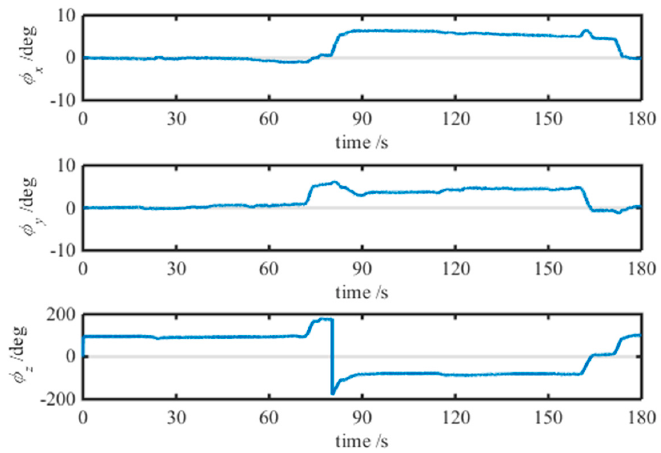
Figure 8. Result of the attitude solution for the SINS.